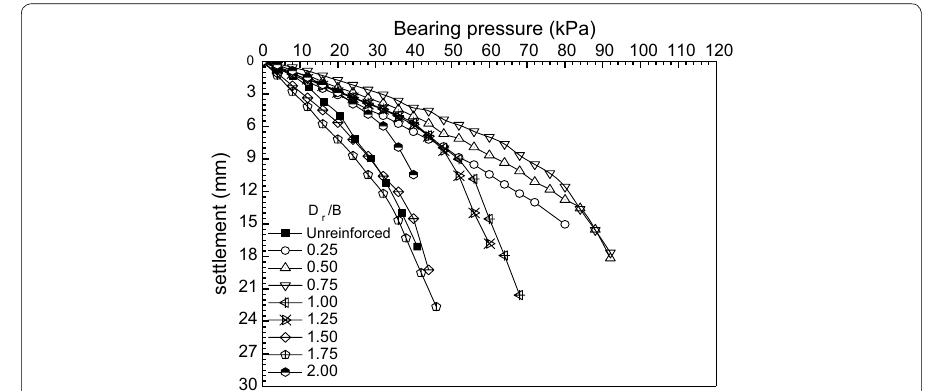
Fig. 4 Bearing pressure-settlement behavior of 75 mm square model footing on geojute reinforced sand